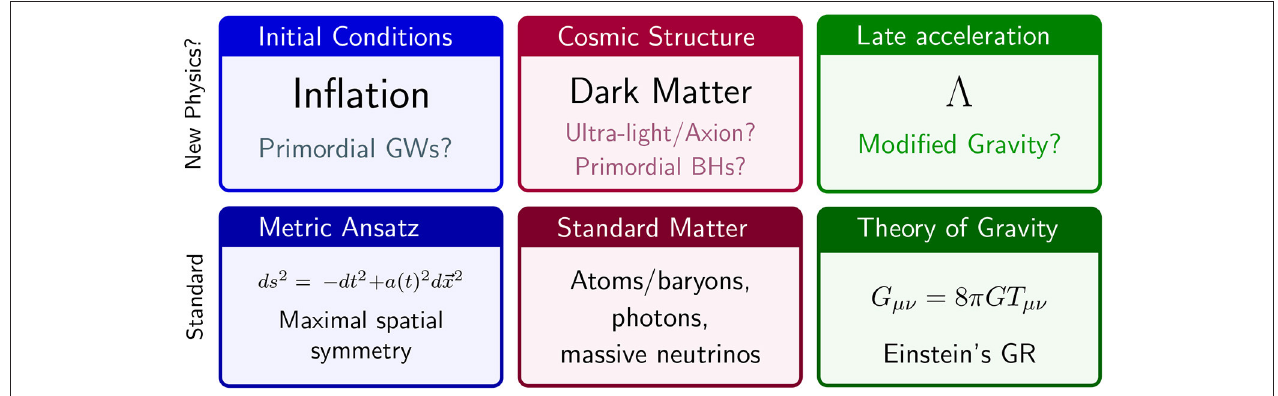
FIGURE 1 | Ingredients of the Standard Model of Cosmology and their possible connection with new